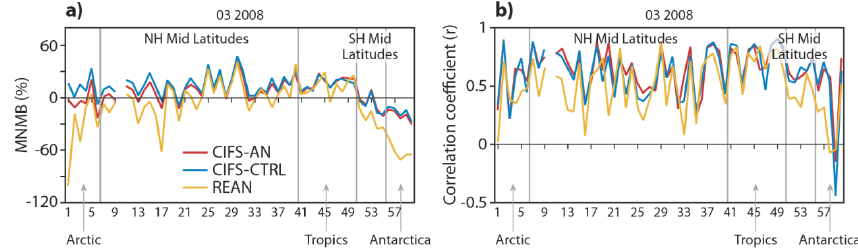
Figure 16. (a) Modified normalized mean biases (MNMBs) in % and (b) correlation coefficients (from daily mean values) for GAW stations during the whole of 2008. The stations are ordered by latitude from north to south. For station numbers see Table S4. CIFS-AN is shown in red, CIFS-CTRL in blue and REAN in